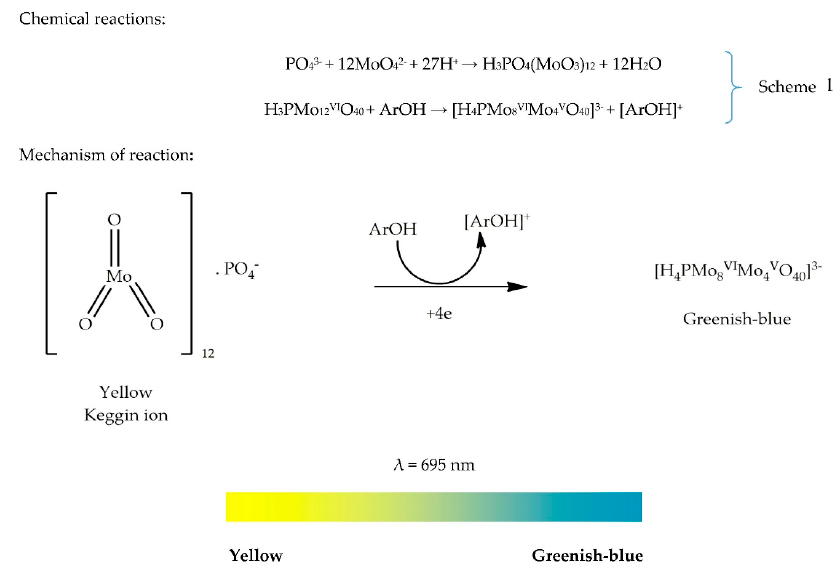
Figure 15. Phosphomolybdenum reaction mechanism.